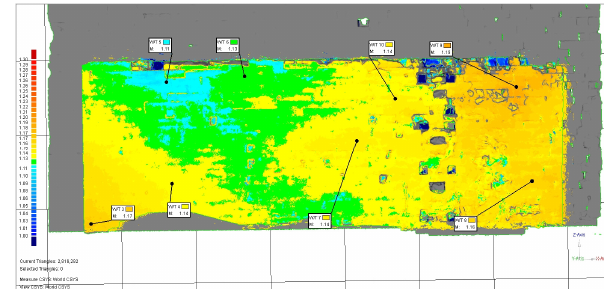
Figure 7: Variations of the wall